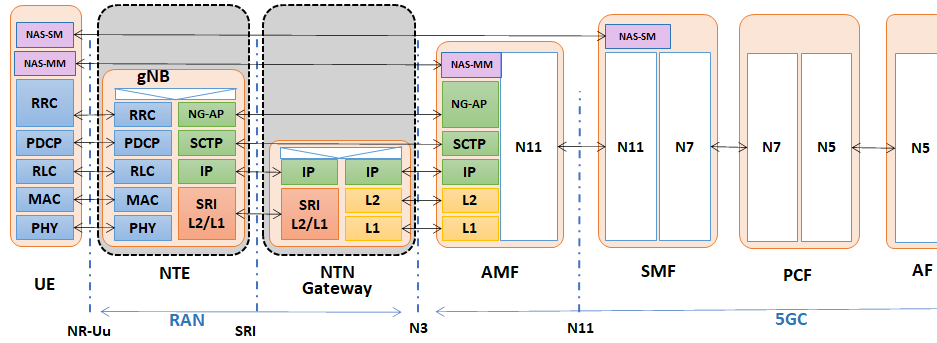
Figure 7. Protocol stack of the control plane in the regenerative NTN architecture [27].